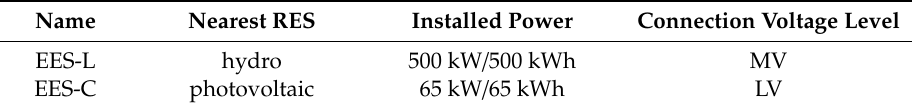
Table 3. Energy storage system (ESS) integrated with the VPP.